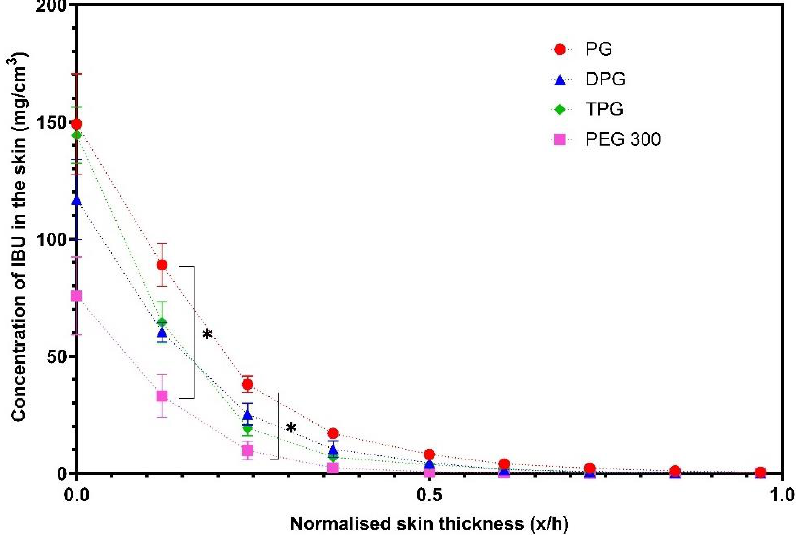
Figure 7. Concentration profiles of IBU (mg/cm 3 ) in the stratum corneum (SC) after application of various formulations (mean ± SEM, 4 ≤ n ≤ 5, * p < 0.05).